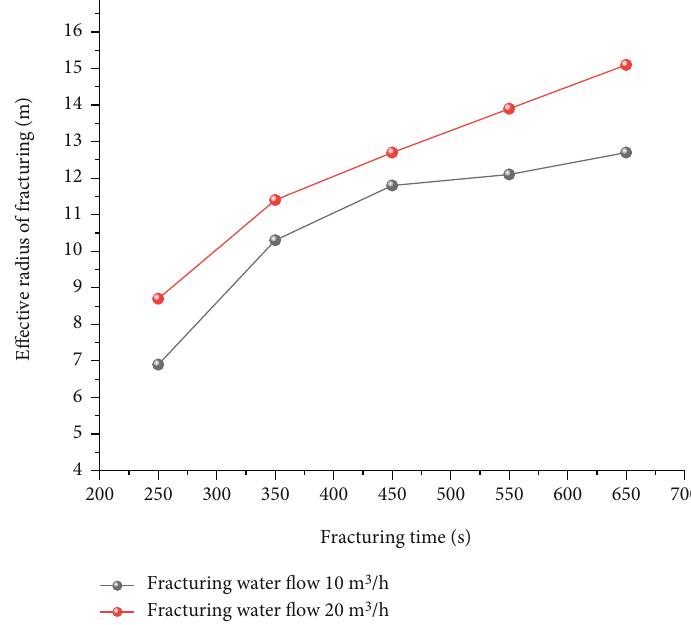
Figure 7: Relationship between e ff ective fracturing radius and fracturing time.